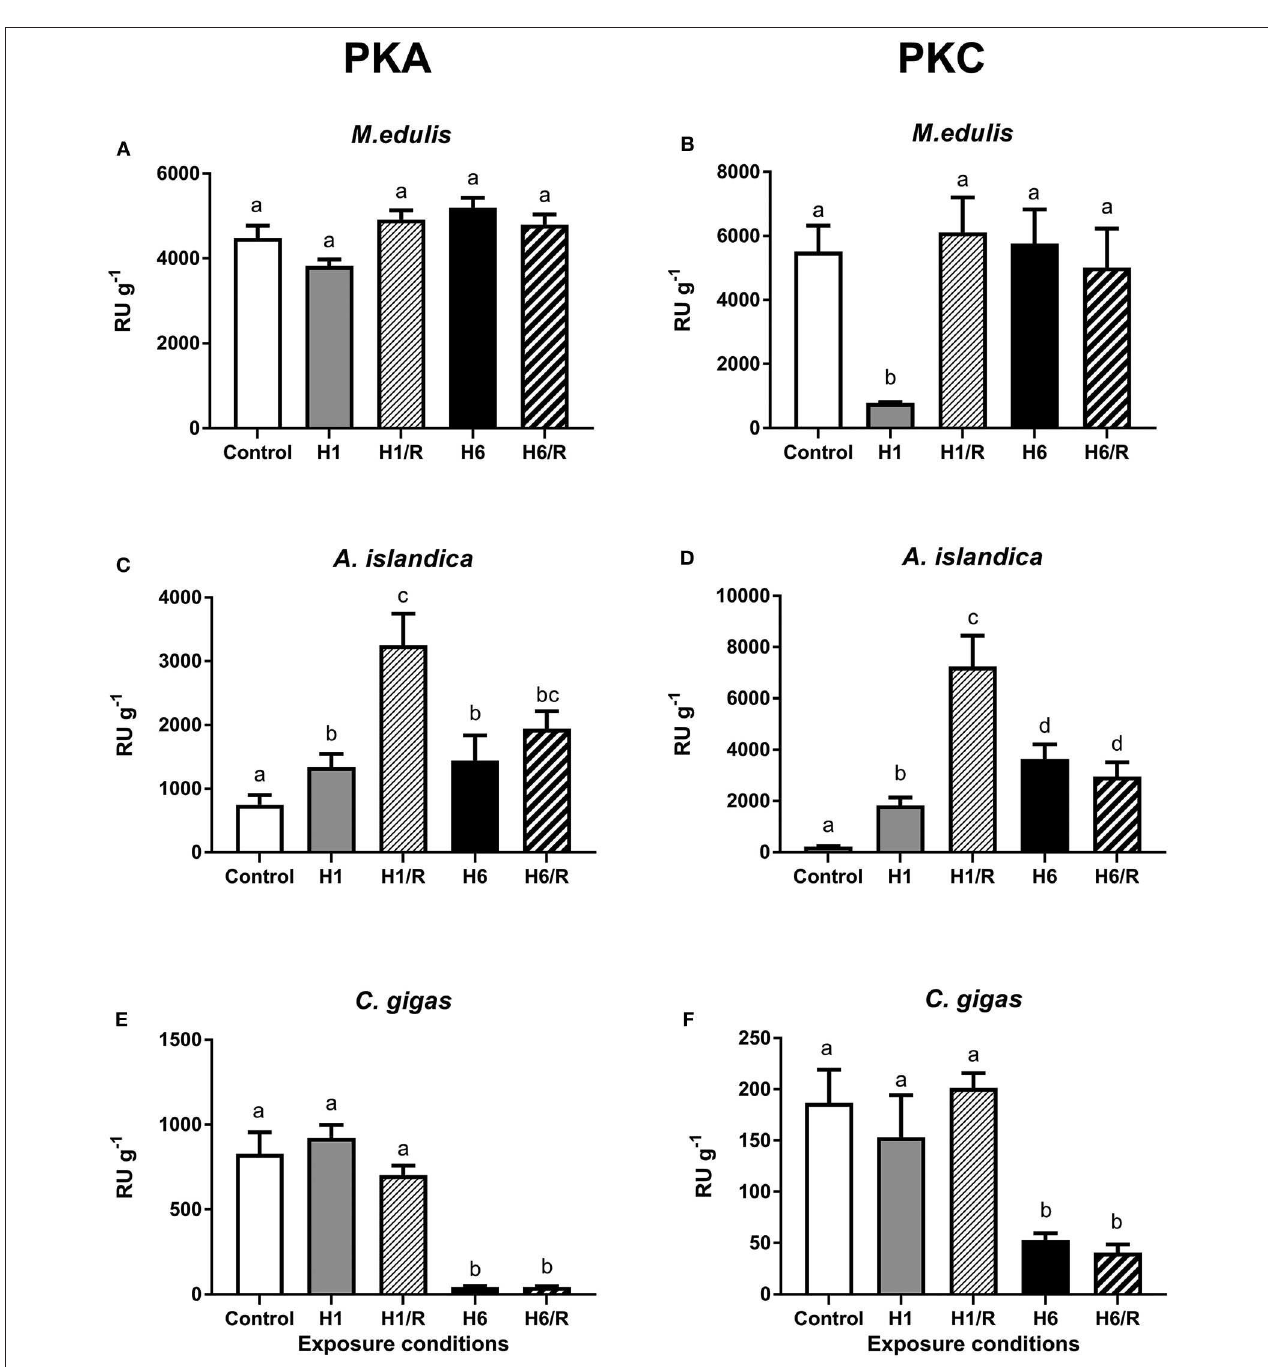
FIGURE 1 | Activities of PKA and PKC in the digestive gland of three species of marine bivalves during the exposure to H/R stress. (A,B) The mussels M. edulis , (C,D) the quahogs A. islandica , and (E,F) the oysters C. gigas . Exposure conditions are control (normoxia), 1 day hypoxia (H1), 1h reoxygenation following 1 day of hypoxia (H1/R), 6 days of hypoxia (H6), and 1h reoxygenation following 6 days of hypoxia (H6/R). Activities are given in relative units (RU) per gram wet tissue mass. Columns that do not share a letter represent significantly different values ( p < 0.05). The vertical bars represent S.E.M. N = 5.